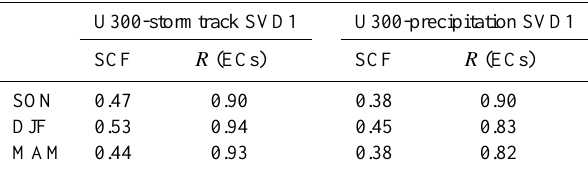
Table 2. Summary of the SVD applied to 300hPa zonal wind and stormtrack and precipitation, in fall, winter and spring: 1st mode (SVD1) squared covariance fraction (SCF) and correlation between the expansion coefficients time-series (ECs).